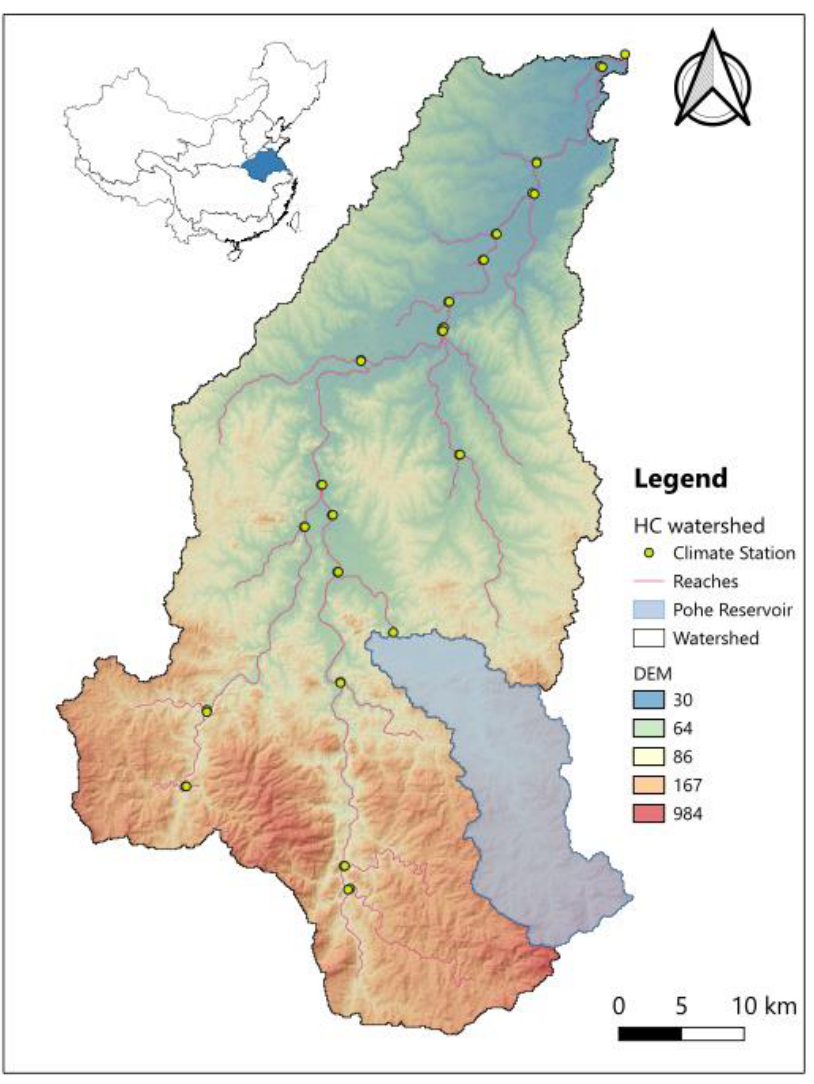
Figure 3. The Huangchuan River watershed map.